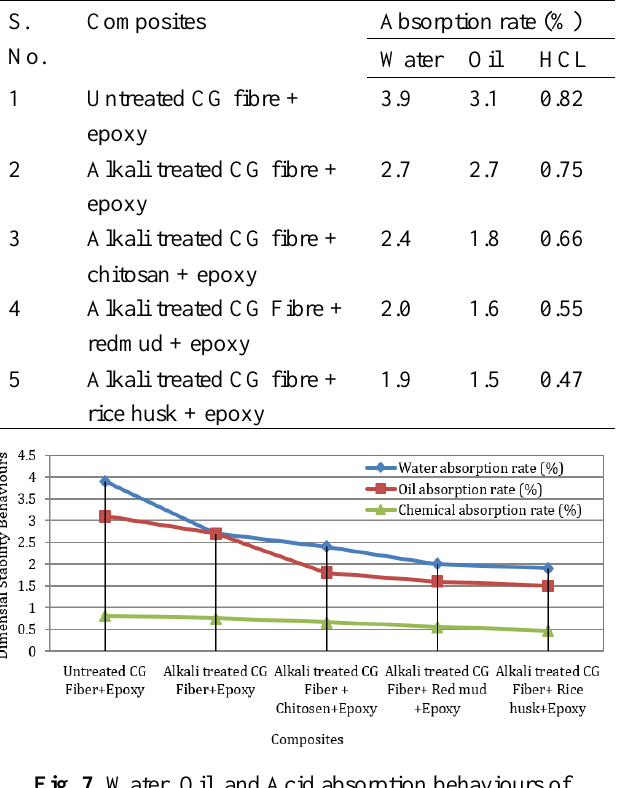
Fig. 7. Water, Oil, and Acid absorption behaviours of Particles-CG-Epoxy